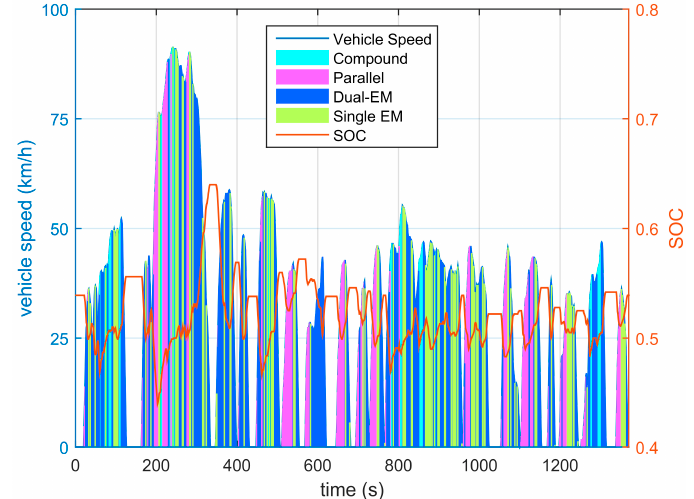
Figure 8. SOC trajectory and mode selection of fuel only ( α = 0.3) over the UDDS cycle.